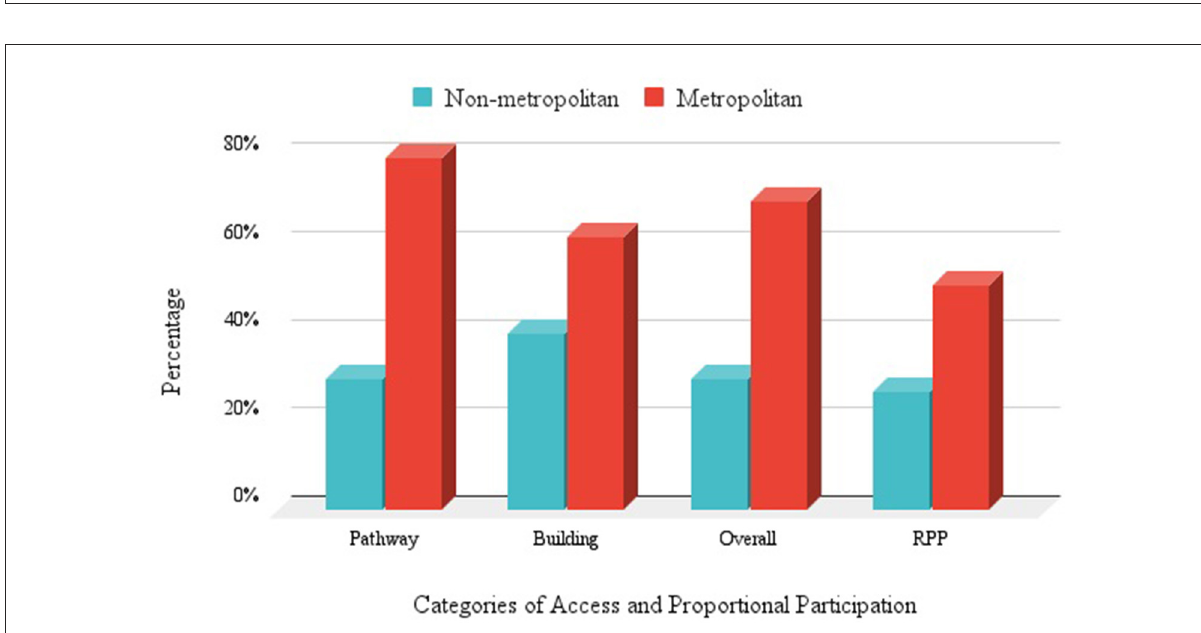
FIGURE4 Rural Access Penalty and Rural Participation Penalty—shows non-metropolitan (blue) vs. metropolitan (red) access features (Pathways, Buildings, and Overall Scores) and participation as measured by the Rule of Proportional Participation (RPP). The metropolitan access and participation rates are consistently higher than non-metropolitan